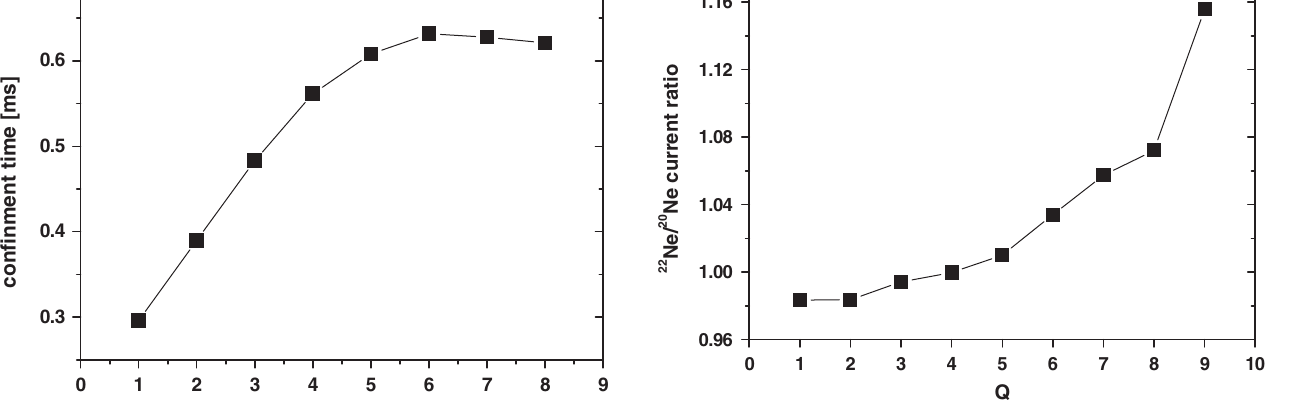
charge state for neon. The plotted confinement times are based on losses of ions to the walls and by ionization to higher charge